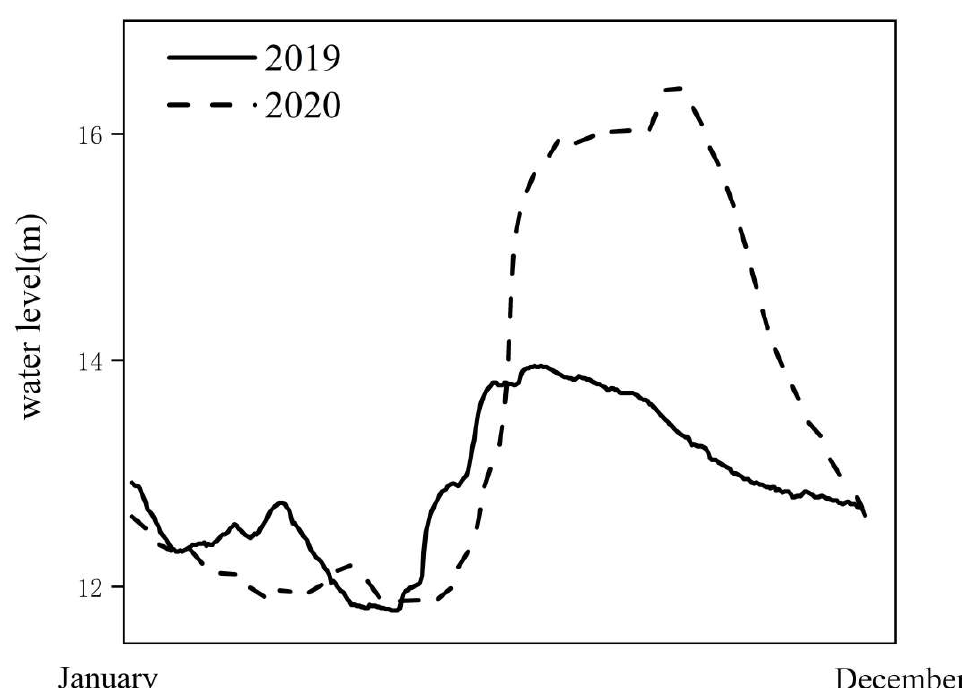
Figure 2. Seasonal variation of water level in Huayanghe River. The solid and dashed lines denote the daily average rainfall in 2019 and 2020, respectively.